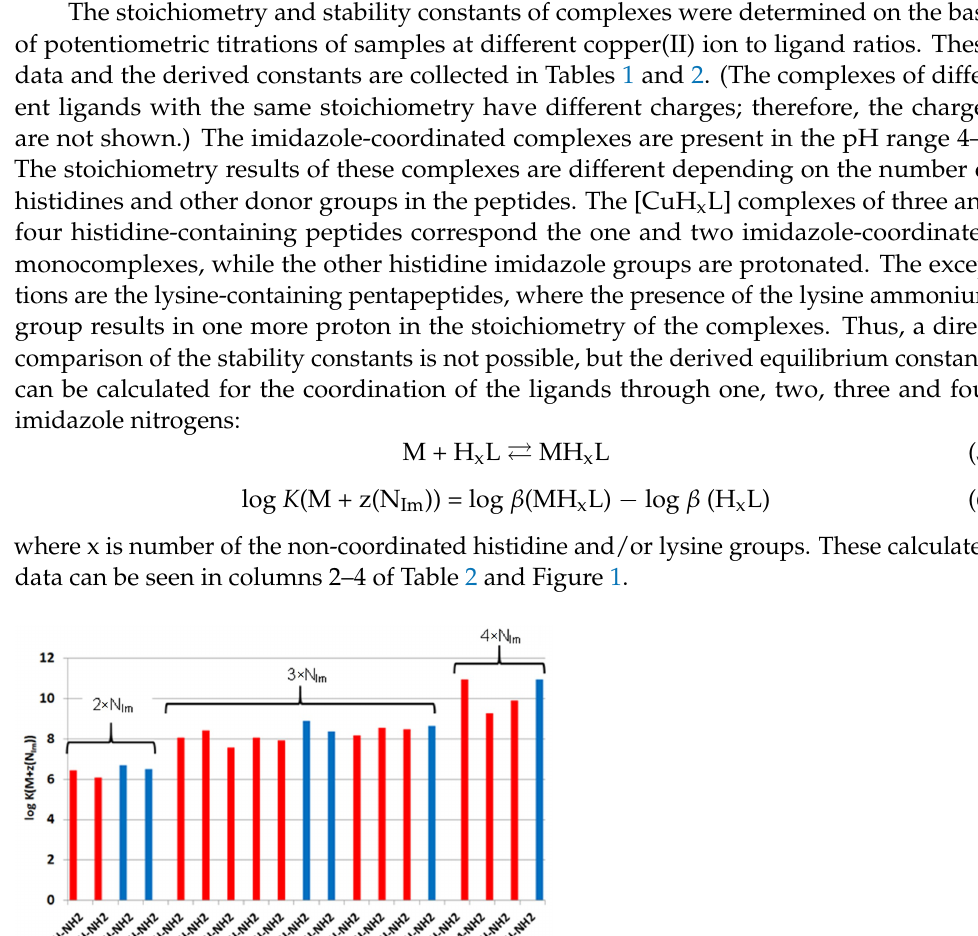
( b ) Figure 2. Distribution of imidazole- and amide nitrogen-coordinated complexes formed in equimolar solution of Cu(II)-Ac-HADH-NH 2 ( ■ ), Cu(II)-Ac-HADHAH-NH 2 ( ■ ) and Cu(II)-Ac- HDHAHDH-NH 2 ( ■ ) ( a ). Cu(II)-Ac-HFHAH-NH 2 ( ■ ) and Cu(II)-Ac-HDHAH-NH 2 ( ■ ) (c L = c M = 2 mM) ( b ).